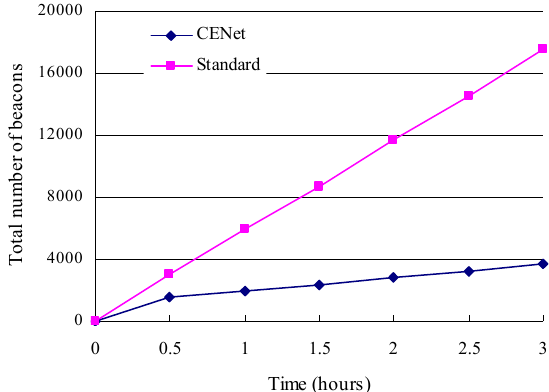
Figure 9. The number of beacons for CENet decreases after a period of time. It is significantly less than that of standard